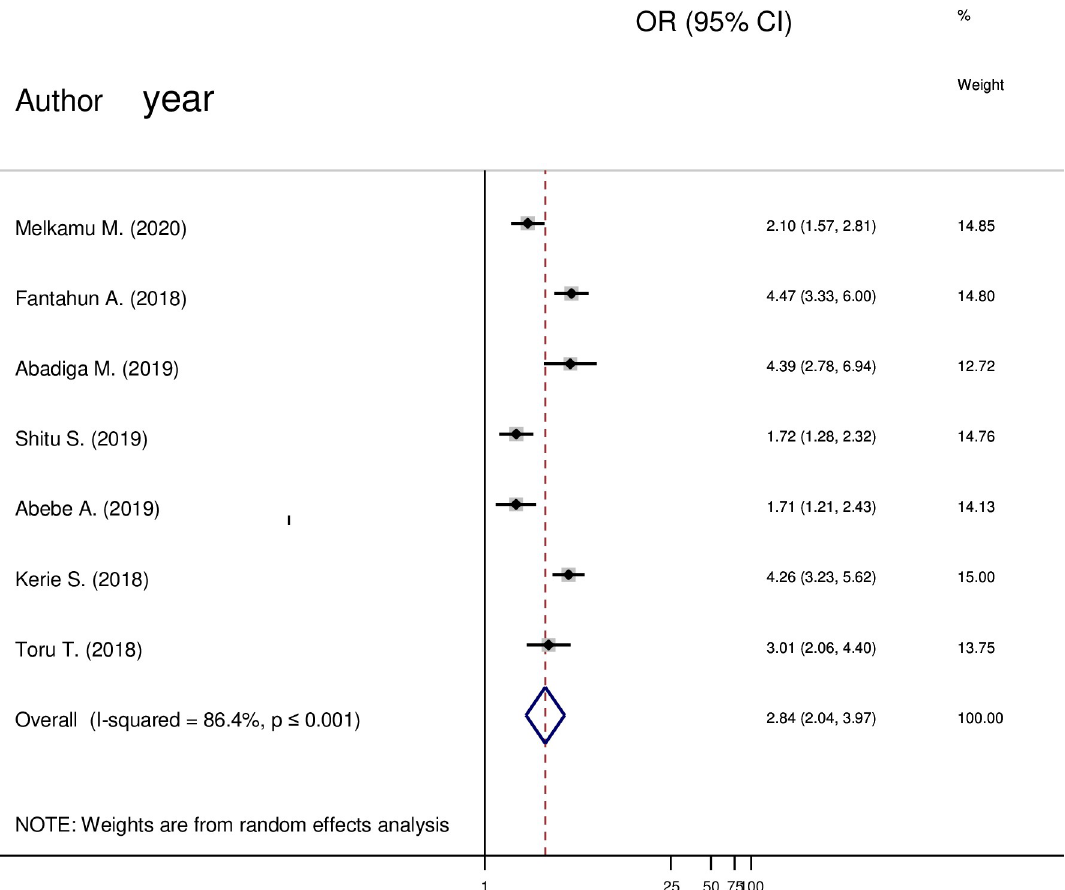
Fig 6. Forest plot pooled random effect size (OR) of unplanned pregnancy-related to planned pregnancy in post-partum depression among mothers in Ethiopia, 2020.